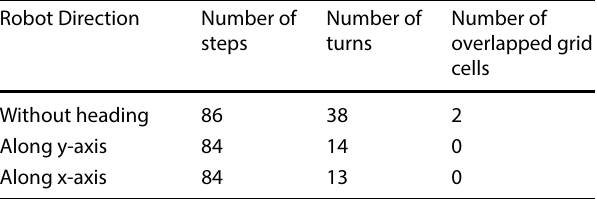
Table 5 Effects of initial heading in mobile robot movement of Fig. 8